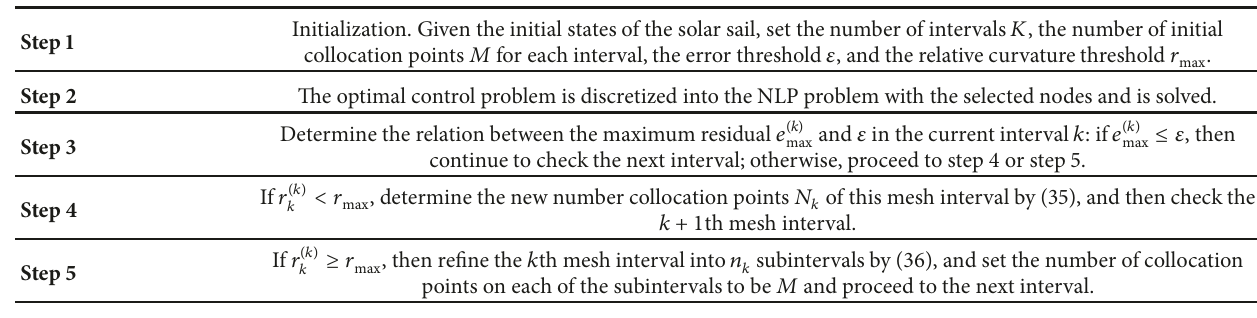
Figure 3: Iterative process of hp -adaptive pseudospectral method. Table 1: Iterative steps of hp -adaptive pseudospectral